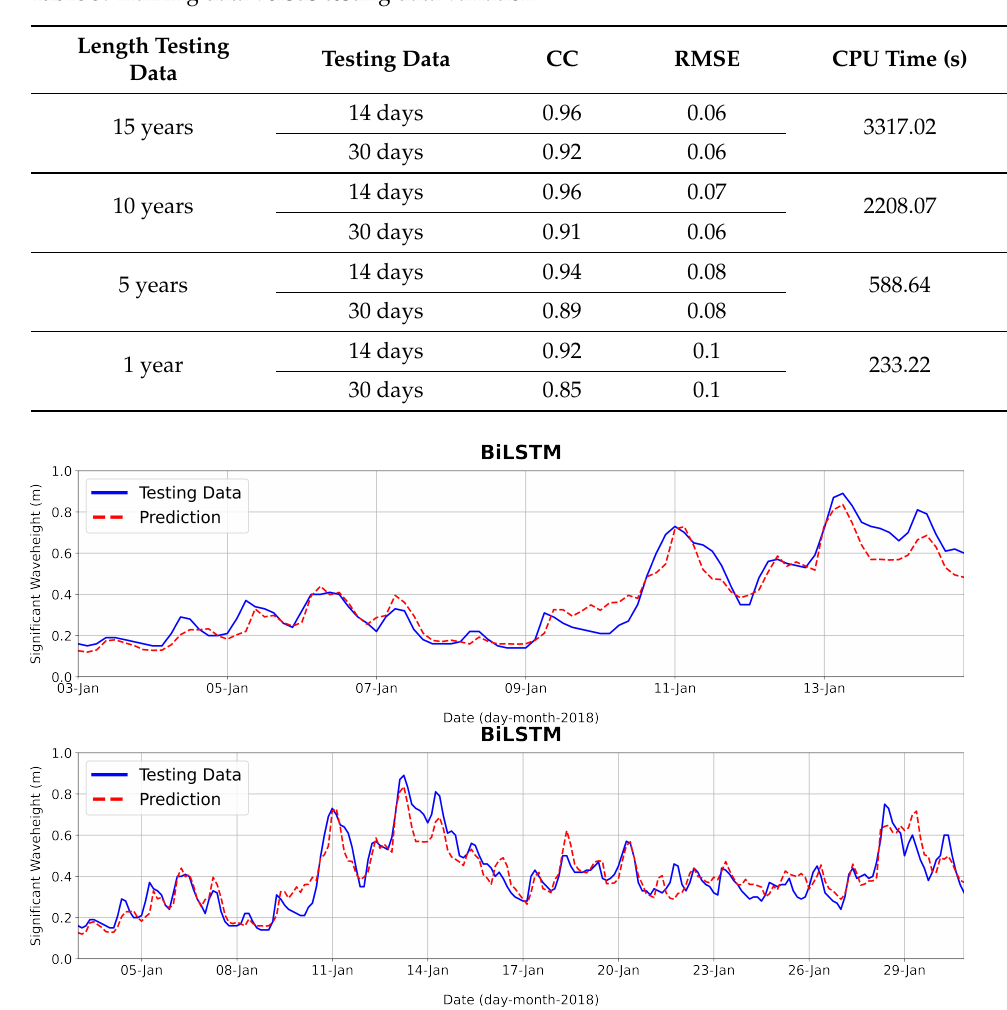
Figure 16. Prediction and testing significant wave height using BiLSTM for 15 years